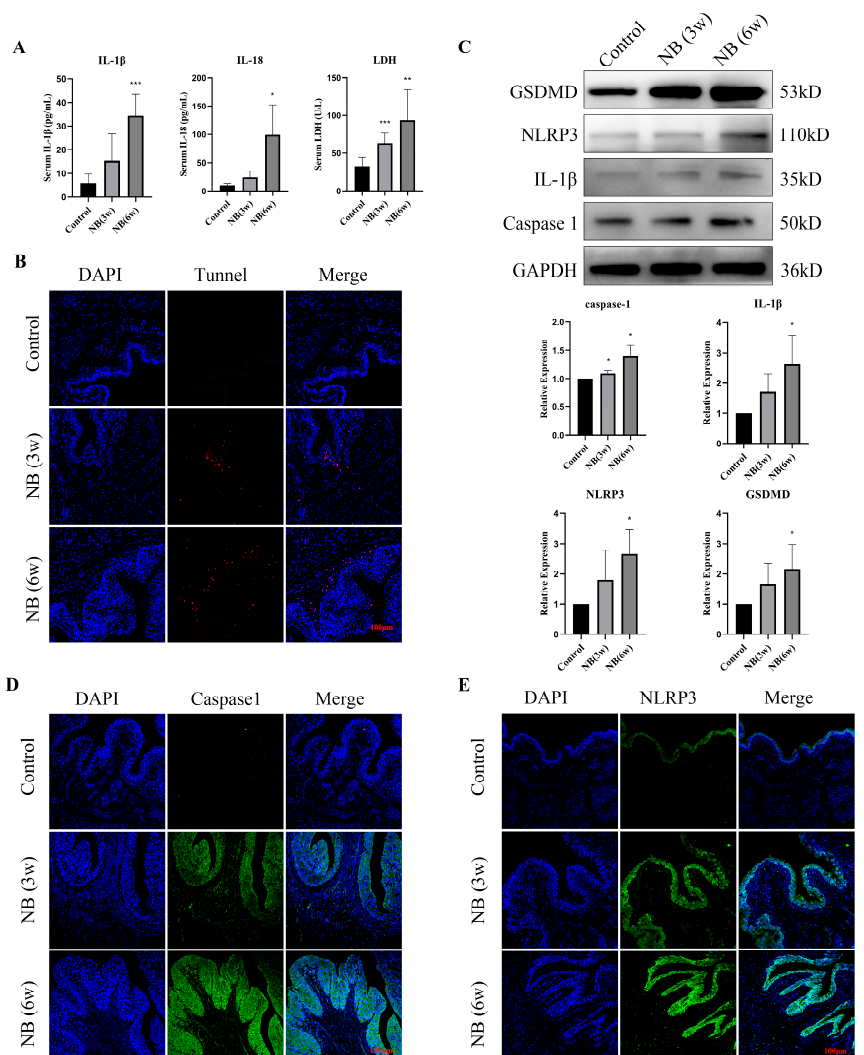
4 Figure 4. Pyroptosis was involved in the process of bladder fibrosis in the bladder after SCI. ( A ) Serum levels of IL-1 β , IL-18 and LDH. ( B ) TUNEL staining of bladder tissue after SCI. ( C ) Western blot bands of NLRP3, GSDMD, IL-1 β and caspase1 and their relative optical density in bladder tissue at different time points after SCI. ( D ) Immunofluorescence of bladder sections showed upregulation of caspase1. ( E ) Immunofluorescence of bladder sections showed upregulation of NLRP3. Data are presented as the mean ± S.D. (n ≥ 3). * p < 0.05; ** p < 0.01; *** p < 0.001. Scale bars, 100 µ